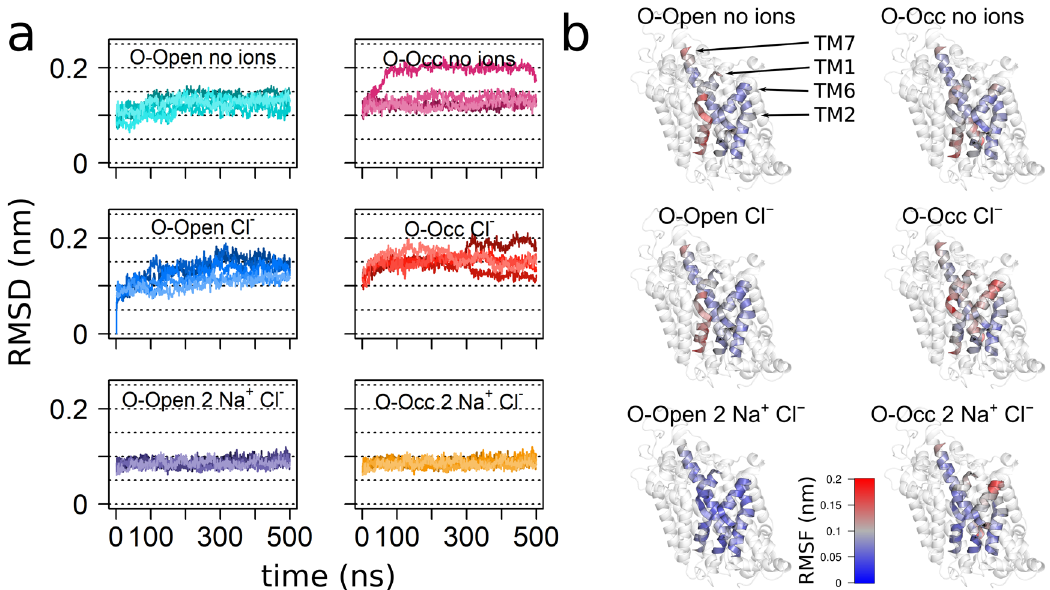
Figure 5. Internal motions of the bundle domain. The internal mobility of the bundle domain decreased, if in the O-Open state and in complex with one Cl − and two Na + ions: ( a ) root-mean- square deviation (RMSD) of the bundle domain after fitting the trajectories to the bundle domain using a 1 ns temporal resolution; ( b ) RMSF of the bundle domain (after fitting to the bundle domain), projected to the mean structure and color coded by the magnitude of fluctuations.